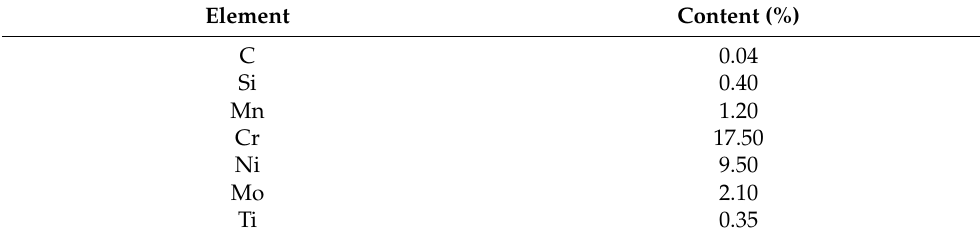
Table 1. Chemical composition of 1.4541 [20].